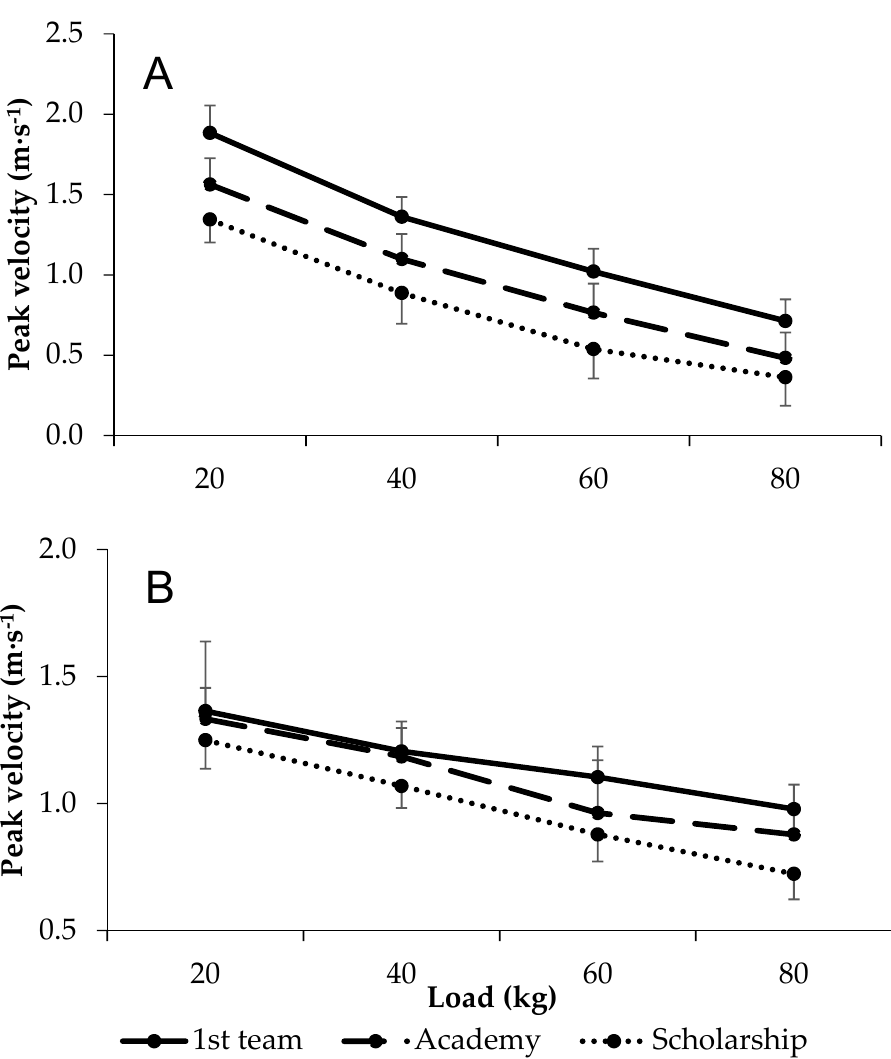
Figure 1. Load–velocity relationships in first team, academy, and scholarship players during the ( A ) bench press and ( B ) squat exercise.